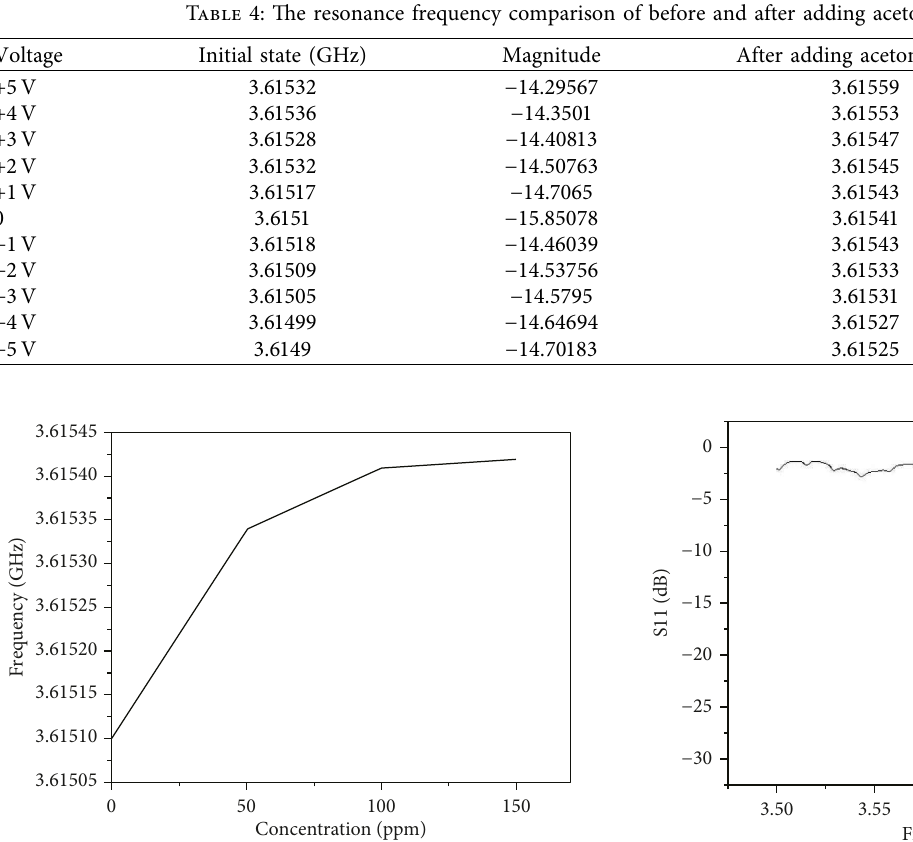
Figure 10: Te concentration measurement results for the acetone samples.